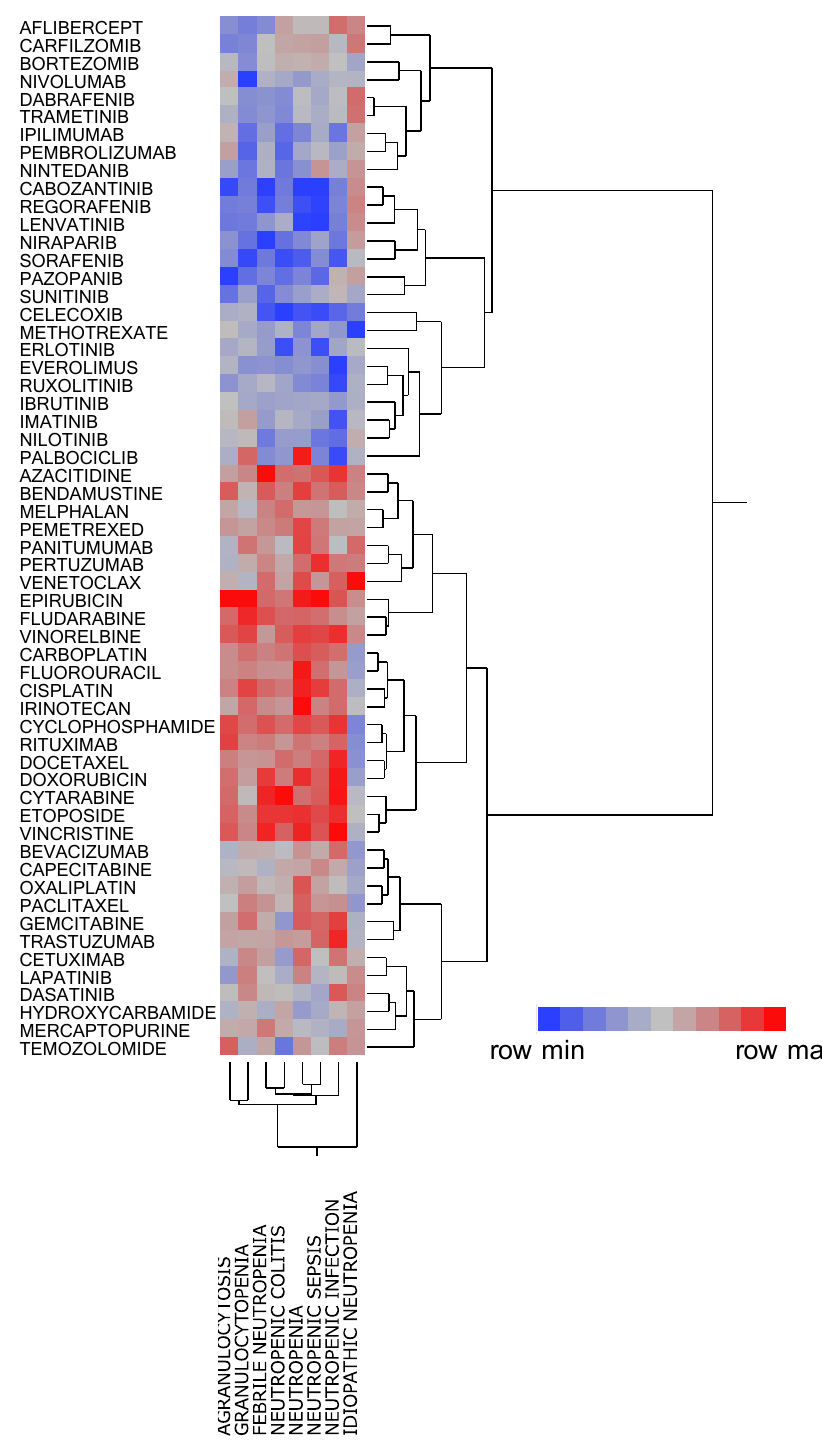
Figure 3. Classification of CIN-related chemotherapeutic agents using hierarchical cluster analysis. The dendrogram shows the relationships between 58 chemotherapeutic agents and CIN. The color map shows the load value of the principal components in red–gray–blue.